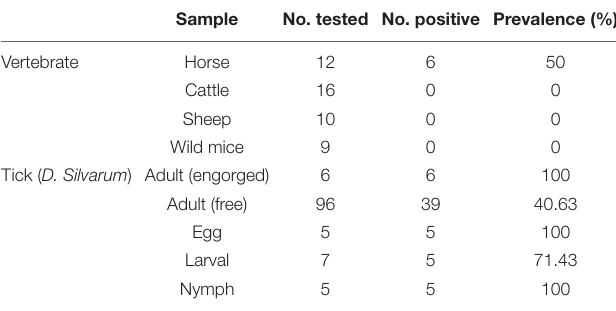
TABLE 1 | The status of Rickettsia raoultii infection in different samples. Sample